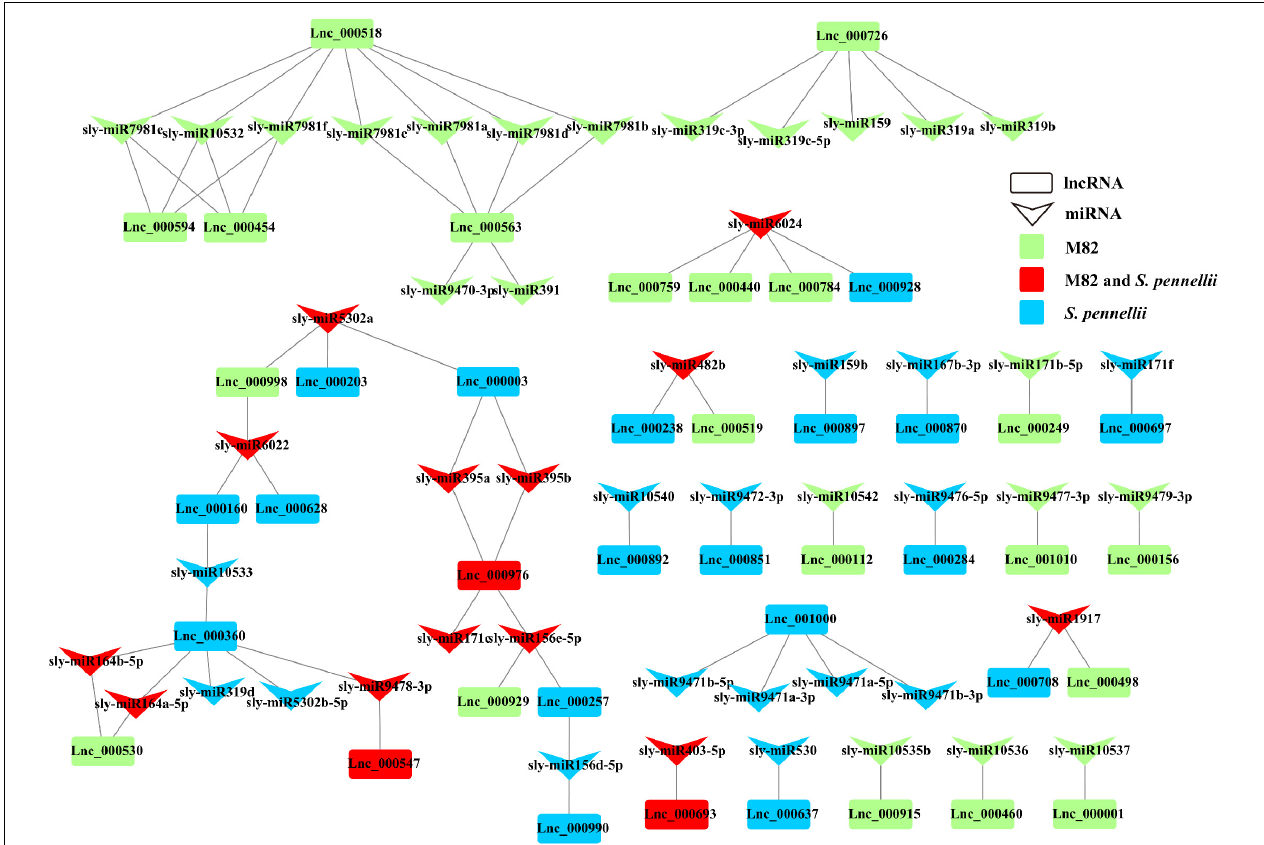
FIGURE 6 | LncRNA–miRNA interaction network. Down arrows refer to miRNAs, rectangles refer to lncRNAs. Green represents the lncRNA that could be targeted by miRNAs only in M82 (or the miRNA that can target DE-lncRNA only in M82). Blue represents the lncRNA that could be targeted by miRNAs only in S. pennellii (or the miRNA that can target DE-lncRNAs only in S. pennellii ). Red represents the lncRNA that could be targeted by miRNAs in both M82 and S. pennellii (or the miRNA that can target DE-lncRNAs in both M82 and S. pennellii